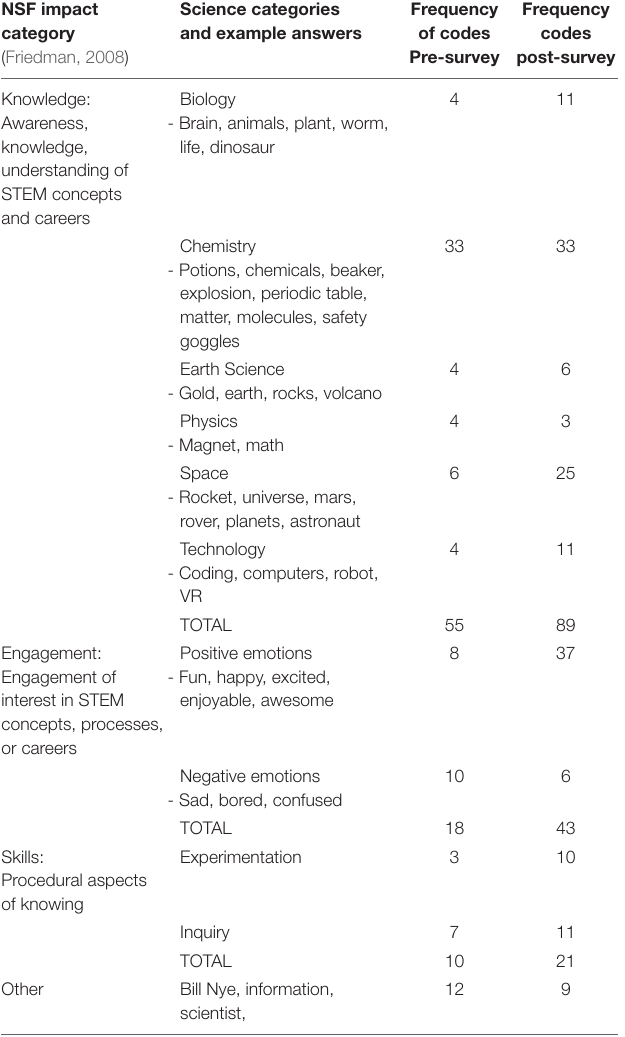
TABLE 4 | Concept Map NSF impact categories and frequency of codes pre and post survey.